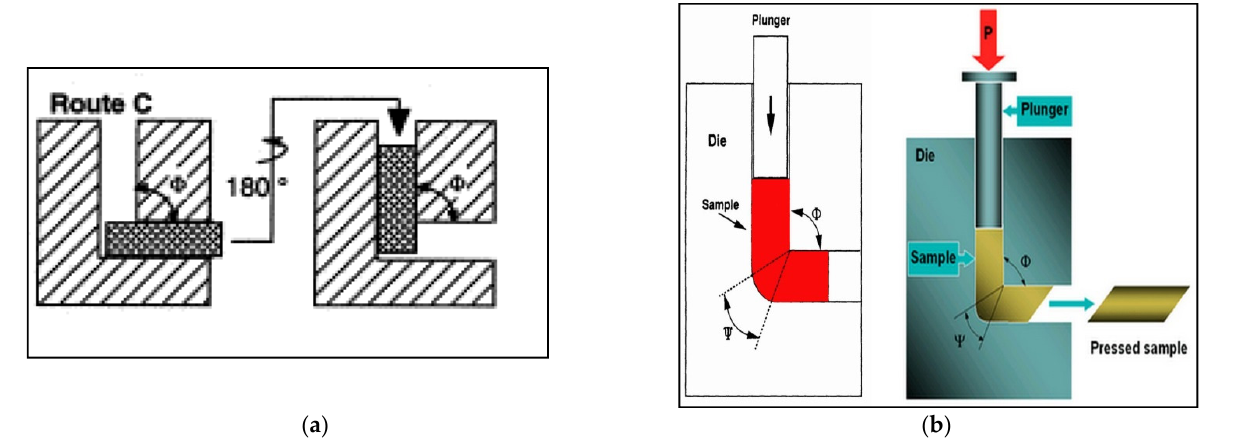
Figure 1. A schematic diagram of equal-channel angular pressing (ECAP) die: ( a ) route C path, ( b ) three-dimensional (3D) presentation of ECAP die.